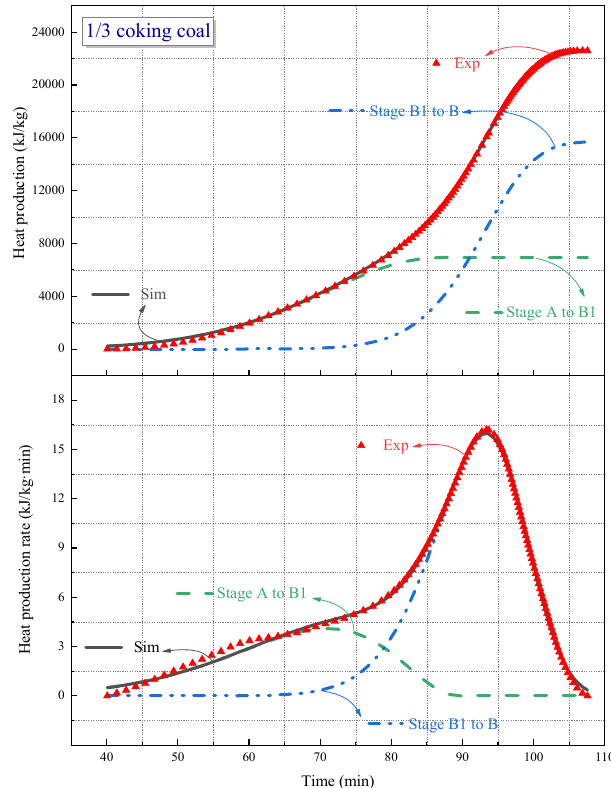
Figure 6. Heat production and heat production rate of 1/3 coking coal at heating rates of 5 °C/min obtained by experiments and simulations.